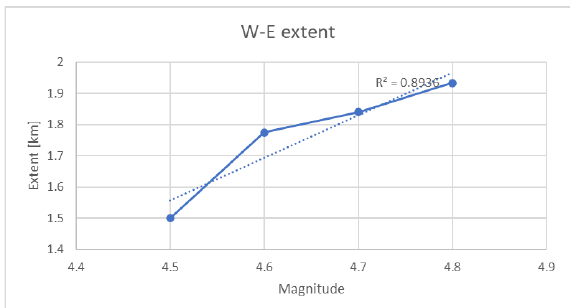
Figure 4. Graph of mean extent of deformation areas in W-E direction and registered magnitude of seismic events